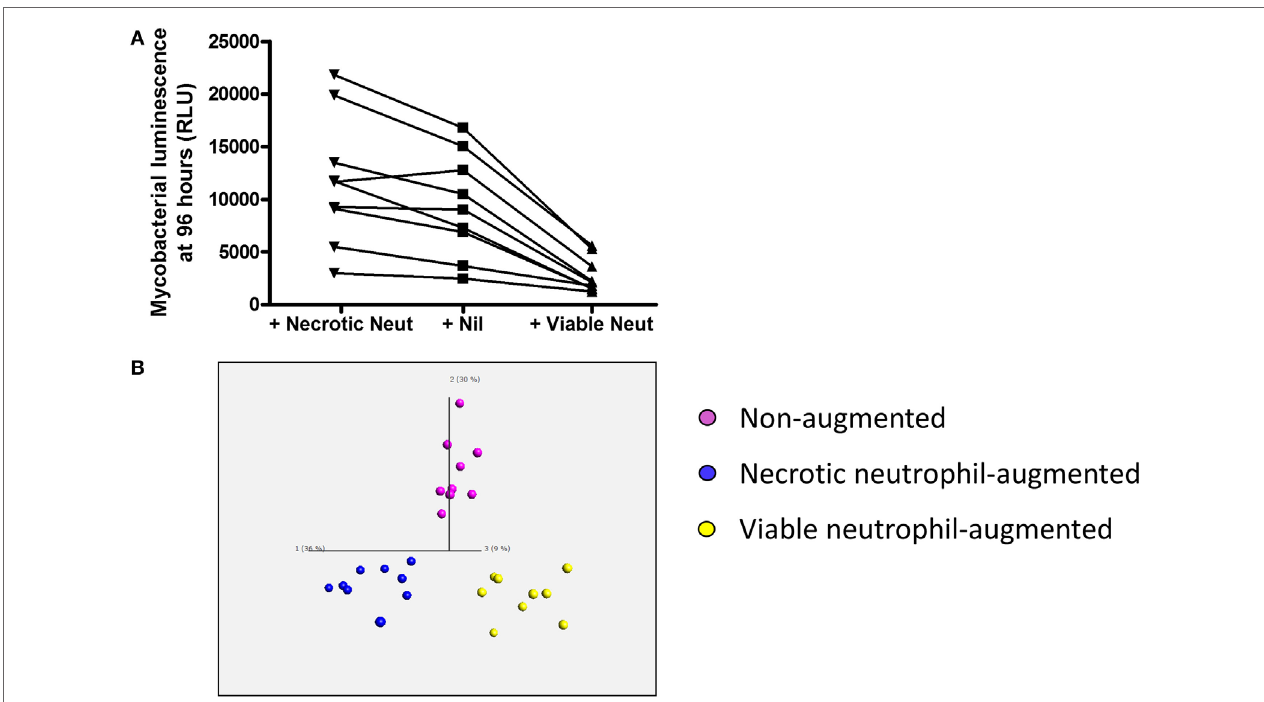
FigUre 3 | Impact of viable and necrotic neutrophil augmentation on control of mycobacterial luminescence by whole blood and on supernatant cytokines and chemokines from Mycobacterium tuberculosis -infected blood. (a) 100,000 RLU of M. tuberculosis -lux in 100 mcl PBS was inoculated into samples of 450 mcl whole blood plus either 450 mcl Percoll-isolated autologous neutrophils in RPMI-1640 heat-shocked at 60°C for 20 min and allowed to cool (“ + Necrotic Neut”), 450 mcl RPMI-1640 only (“ + Nil”), or 450 mcl room temperature Percoll-isolated autologous neutrophils in RPMI-1640 (“ + Viable Neut”). After 96-h incubation, red blood cells were lysed and luminescence was measured on at least two aliquots of 100 mcl. Results are shown from nine independent donors. (B) Three- dimensional principal component analysis (PCA) plot generated using cytokine/chemokines that significantly contribute to differentiation between supernatants of augmentation conditions (calculated using multi-group comparison; purple = non-augmented, blue = necrotic neutrophil-augmented, yellow = viable neutrophil- augmented). PCA is a technique to reduce the dimensionality of complex datasets by transforming the data to a coordinate system. The first three coordinates (principal components) are represented as a 3D plot. The first principal component accounts for as much variability as possible within the data, and each succeeding component accounts for the next highest proportion of the variability possible, but under the constraint that it is not correlated with preceding components. This allows visualization of the differences between patient samples and analytes within complex datasets. Individual points represent one donor in one augmentation condition and their position in the plot is determined by the combined effects of all parameters measured for the sample that significantly contribute to the overall between-group difference. Component vectors for the three main components are displayed, along with a percentage figure signifying the proportion of the variability in the data that each component accounts for. Analysis is presented using raw values from infected